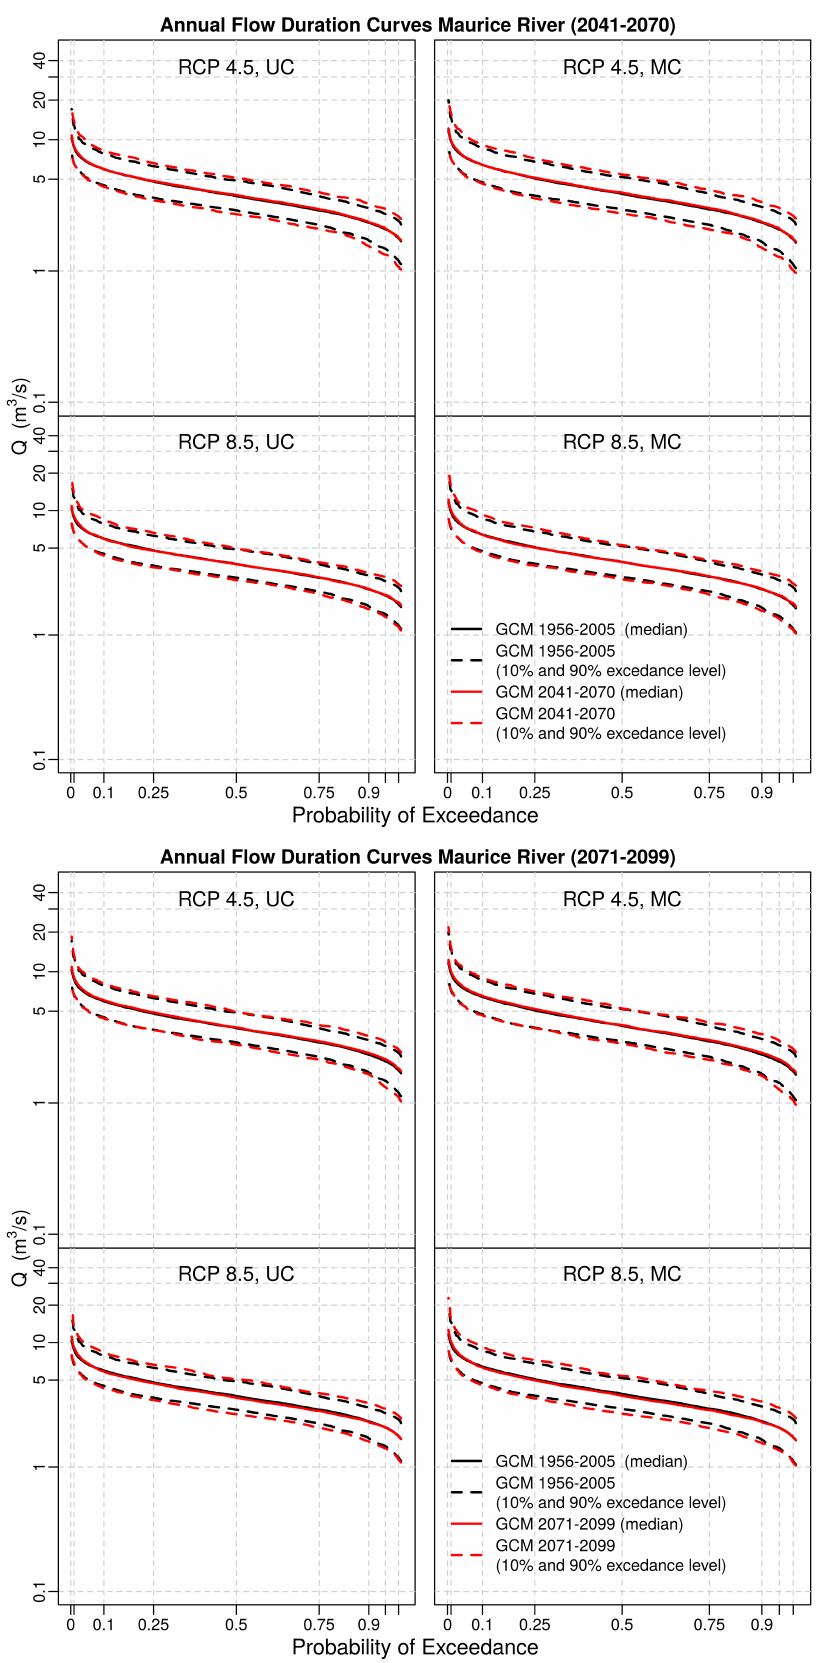
Figure 11. Projected flow duration curves for the Maurice River under emission scenarios RCP 4.5 and 8.5 for the two time slices as